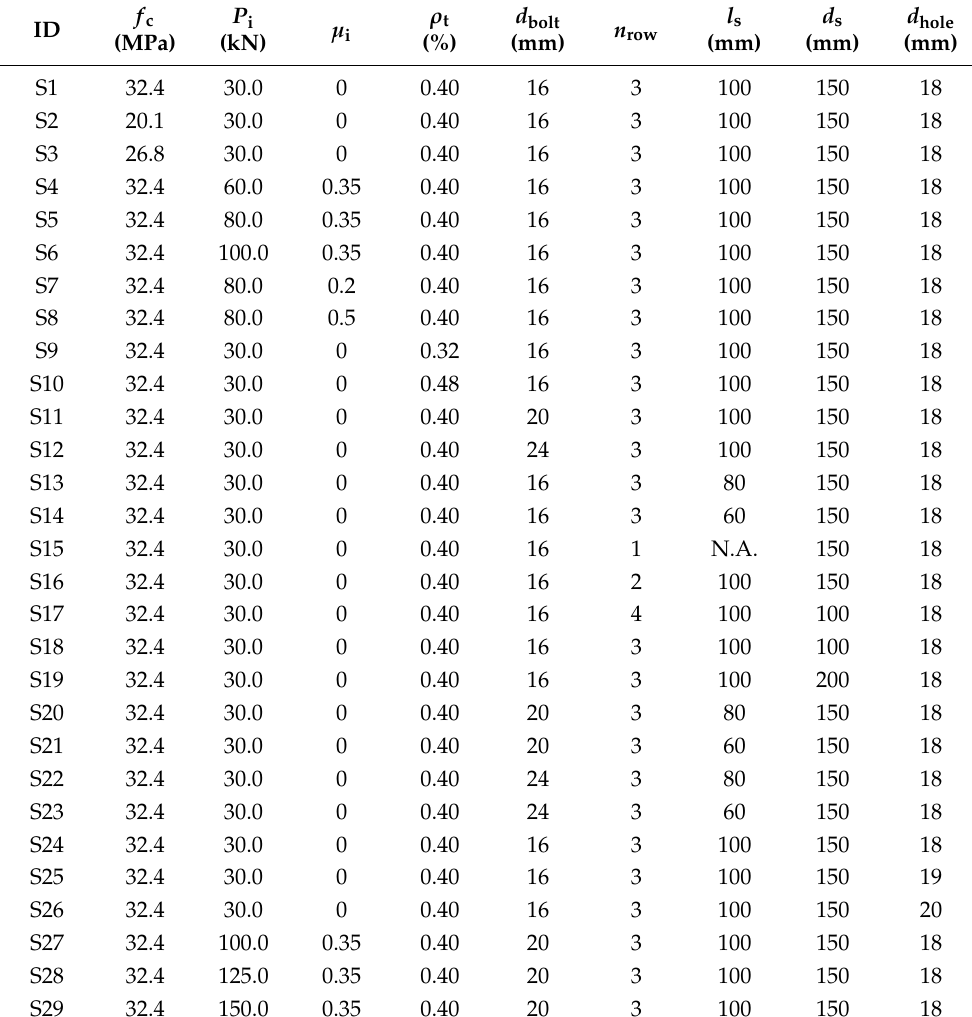
Table 4. Parametric design of FE